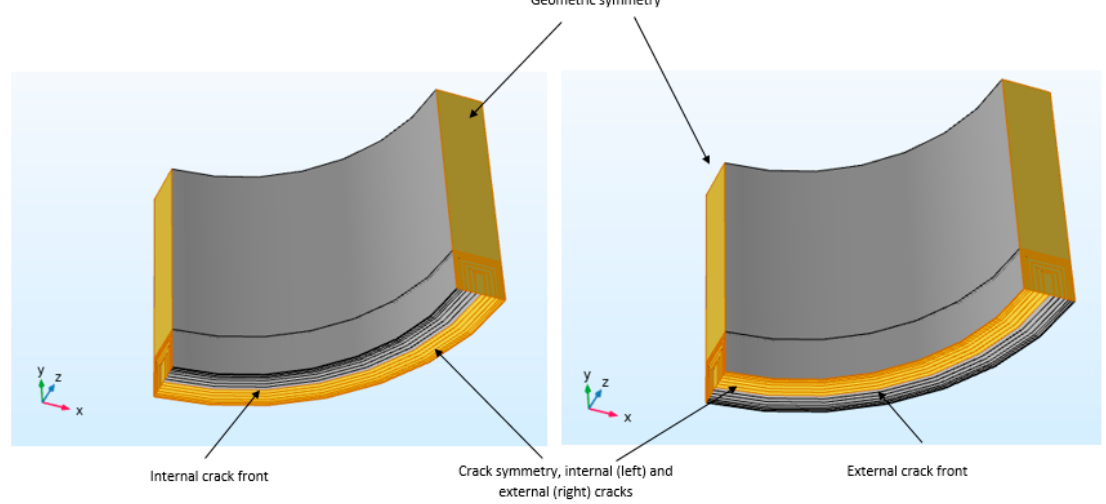
Figure 3 . Boundary conditions applied for internal and external cracks.